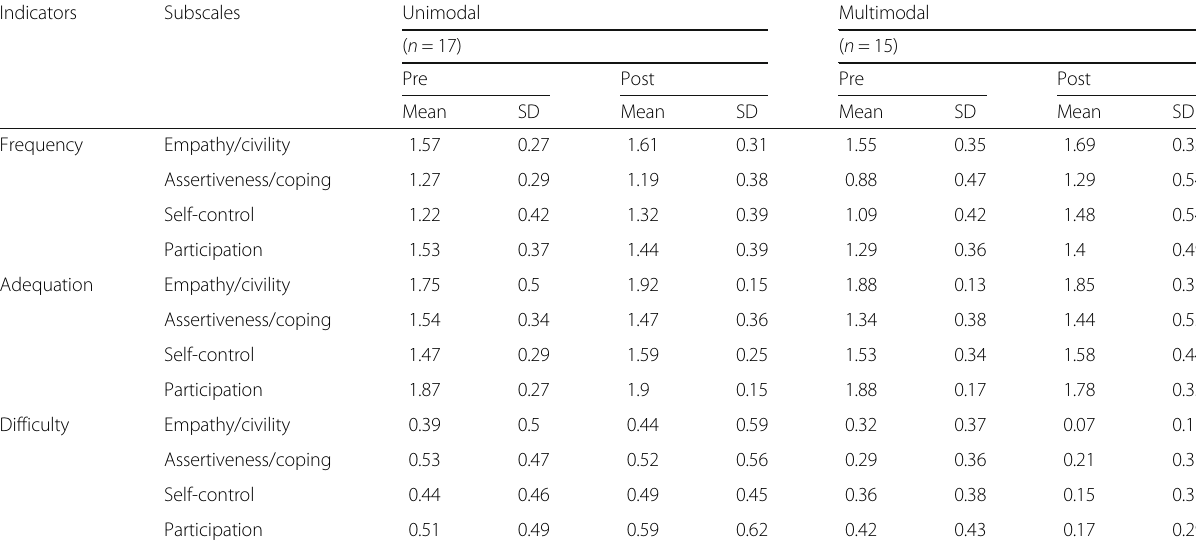
Table 5 Mean pre- and post-treatment social skill scores Indicators